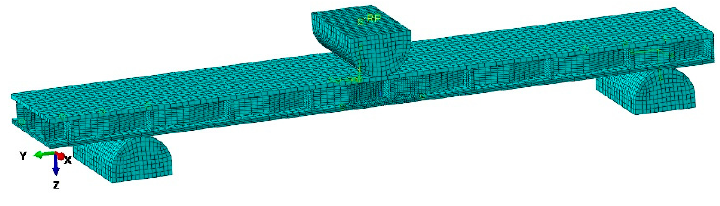
Figure 6. Mesh model of the multilayered beam.